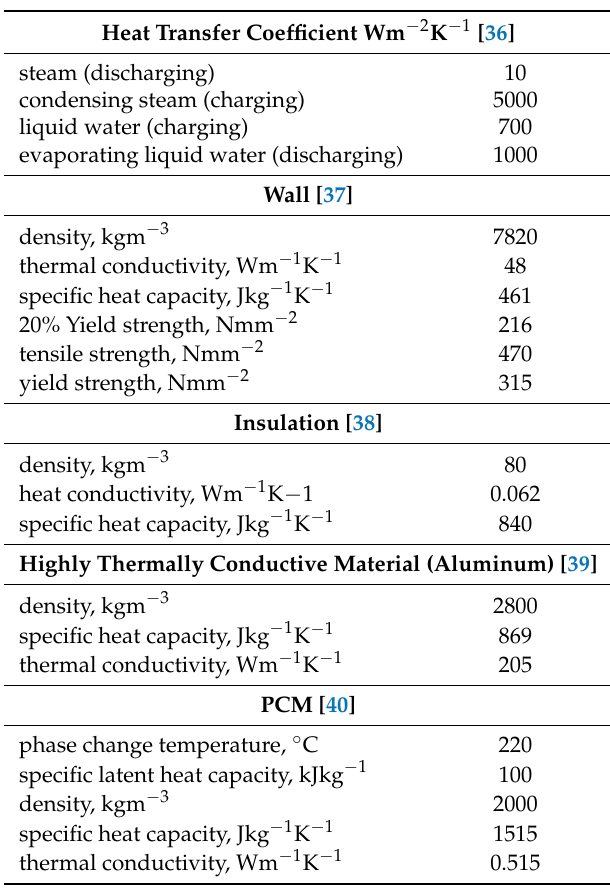
Table 5. Material